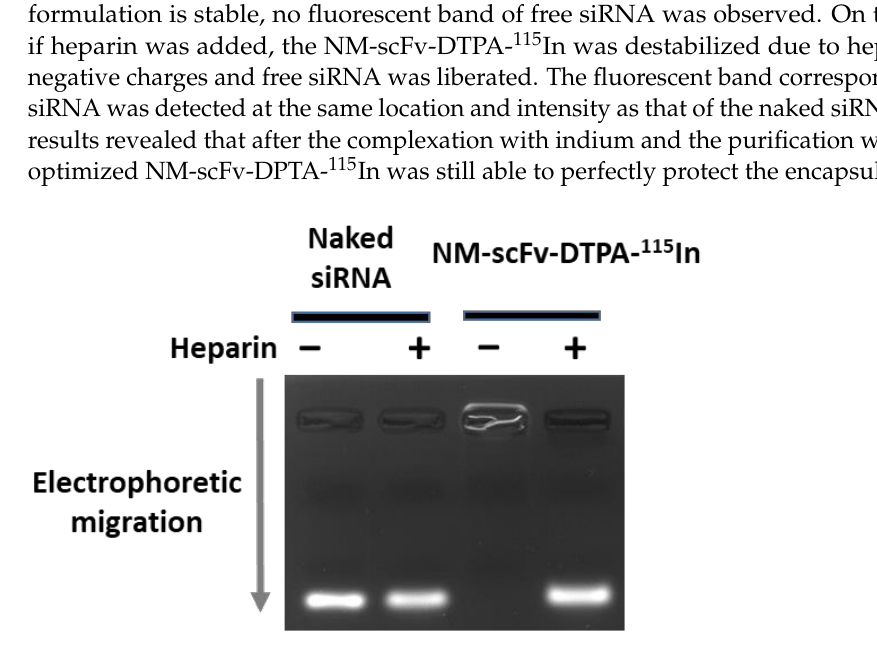
Figure 4. Gel retardation assay to detect free siRNA in the optimized NM-scFv-DTPA- 115 In (DTPA/Fe molar ratio: 0.3) with (+) or without ( − ) heparin.